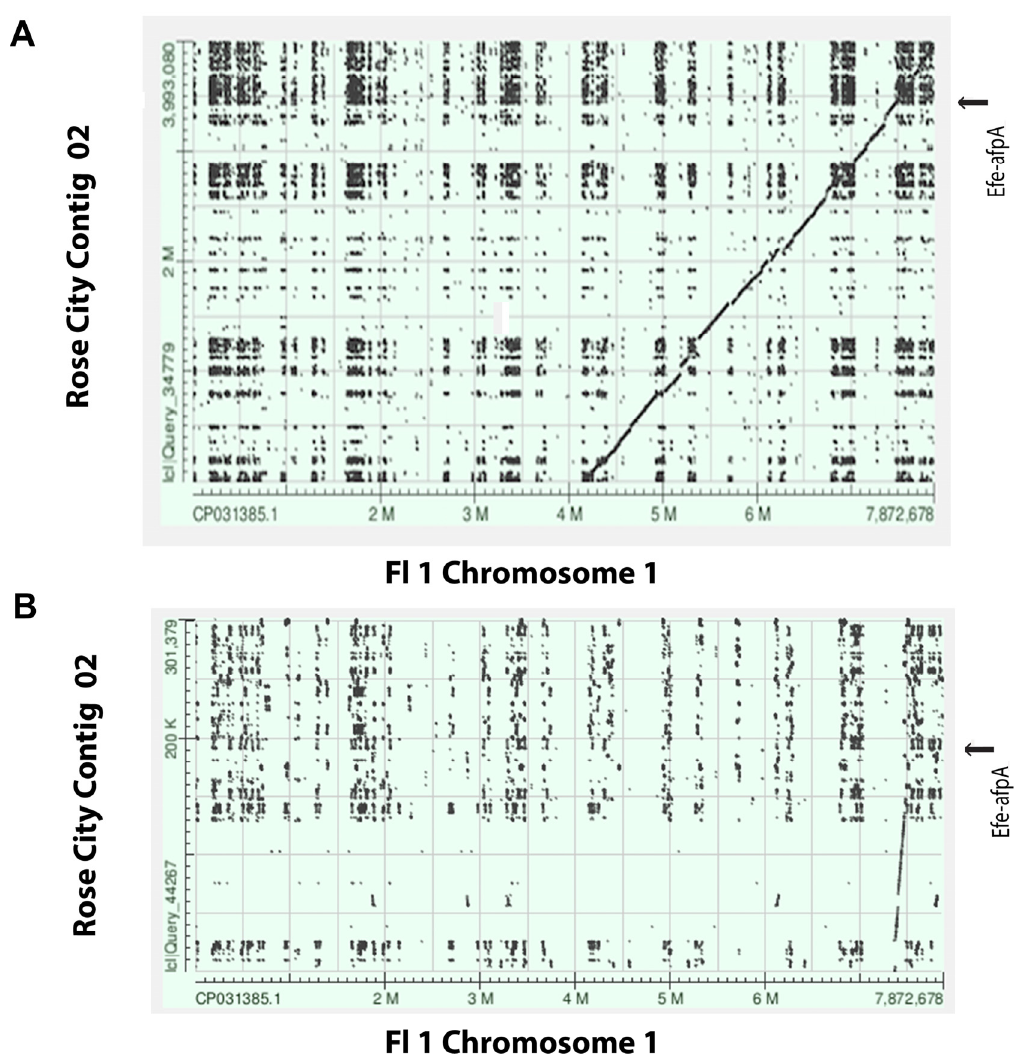
Figure 5. ( A ). Screen shot of dot plot comparison of the E. festucae Rose City isolate PacBio contig 02 sequence with the Fl1 chromosome 1 sequence. ( B ). Screenshot of the dot plot region of Rose City contig 02 sequence that contains Efe-afpA with the Fl1 chromosome 1 sequence. The arrows indicate the position of Efe-afpA in the Rose City sequence.